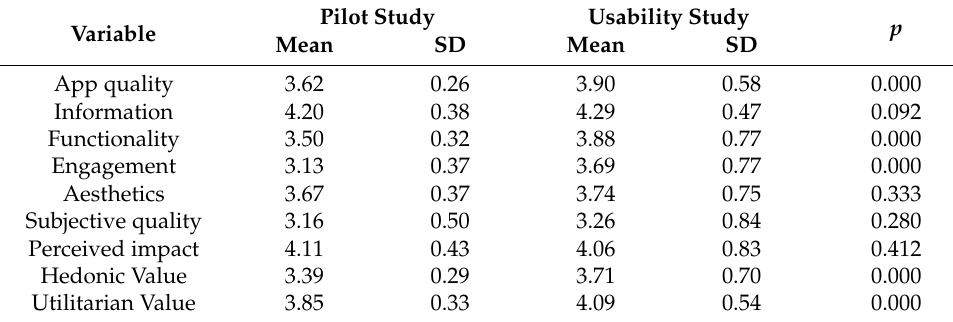
Table 2. Comparison of Pilot Study and Usability Study